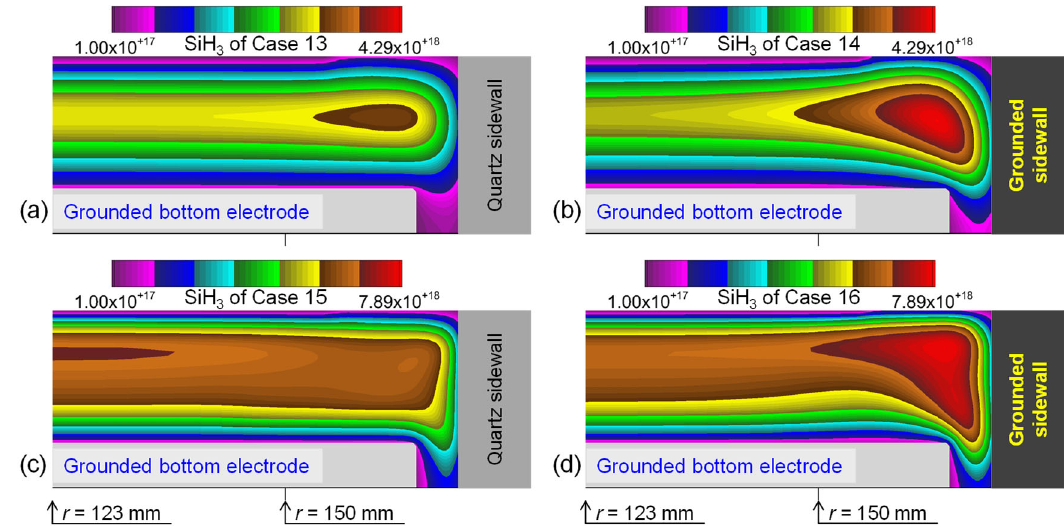
Figure 14. The spatial profiles of the time-averaged SiH 3 density (m − 3 ) ( a ) for Case 13, ( b ) for Case 14, ( c ) for Case 15, and ( d ) for Case 16.